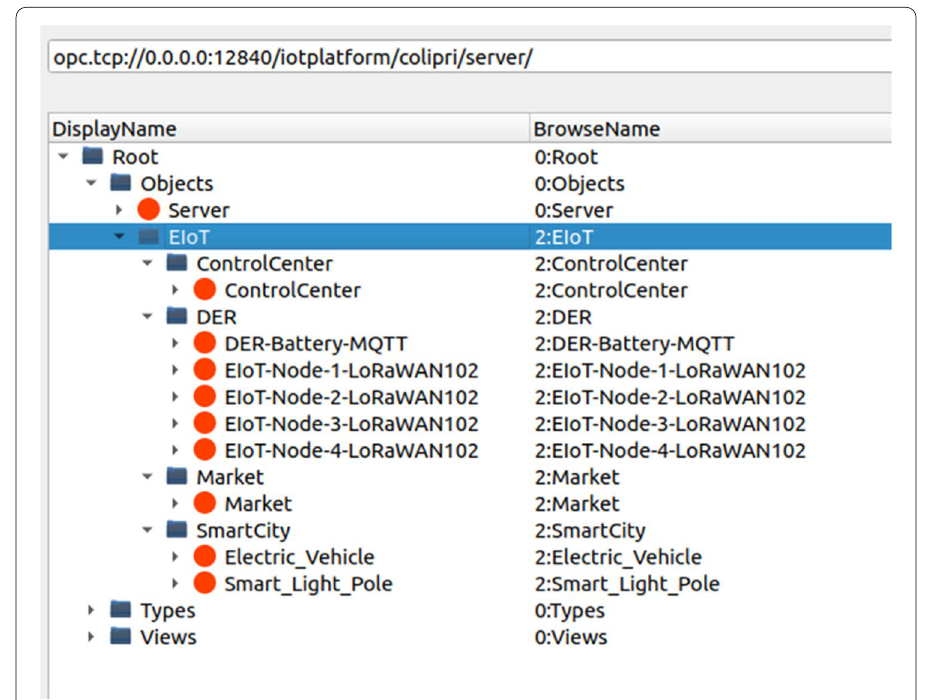
Fig. 7 OPC UA network discriminated by agent